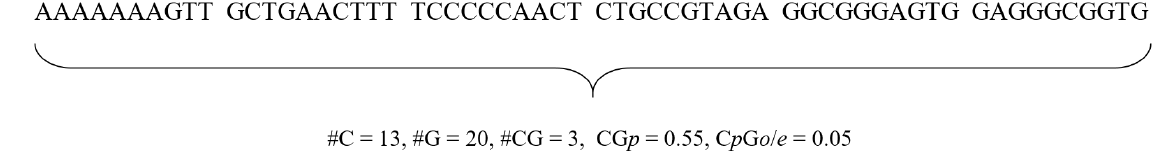
Figure 1. CpG island features. The values of C , G , and CG are 13, 20, and 3, respectively. Thus, CGp = p(C)+ p(G) = 0.55, and CpGo = p(CG)/(p(C)p(G)) =